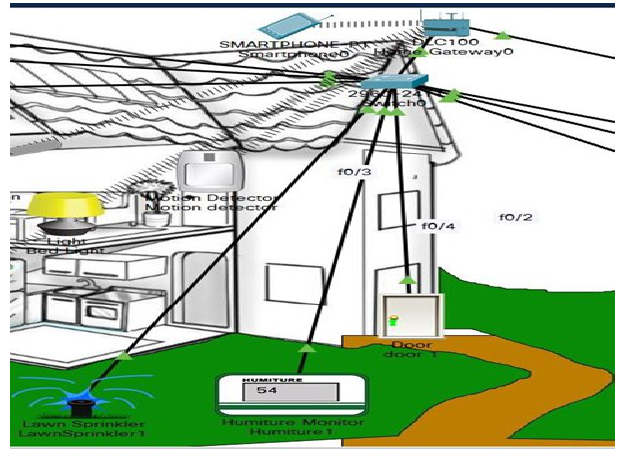
Fig. 5. Above shows the connection for the humiture monitor HUMITURE MONITOR: This sensor detects the outdoor temperature and humidity of the environment and turns the lawn sprinkler on and off accordingly. The conditions upon which the humiture monitor will operate are as follows -